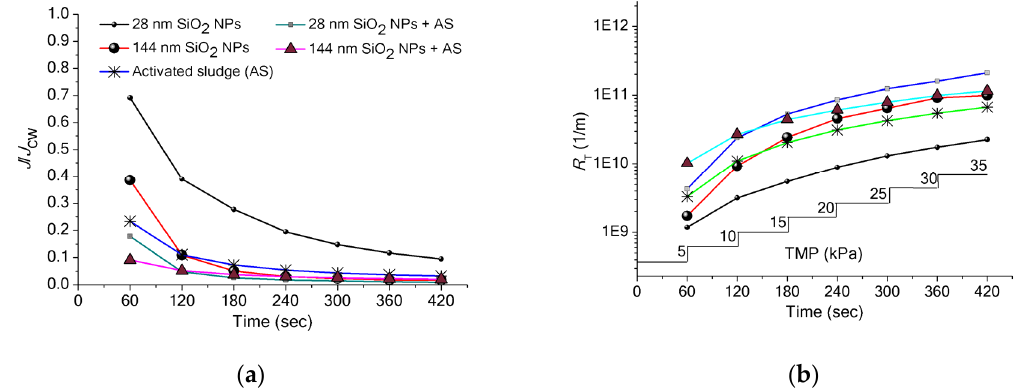
Figure 7. Membrane filtration characteristics in dead-end filtration of activated sludge with SiO 2 NPs. ( a ) normalized permeate flux and ( b ) total resistance.